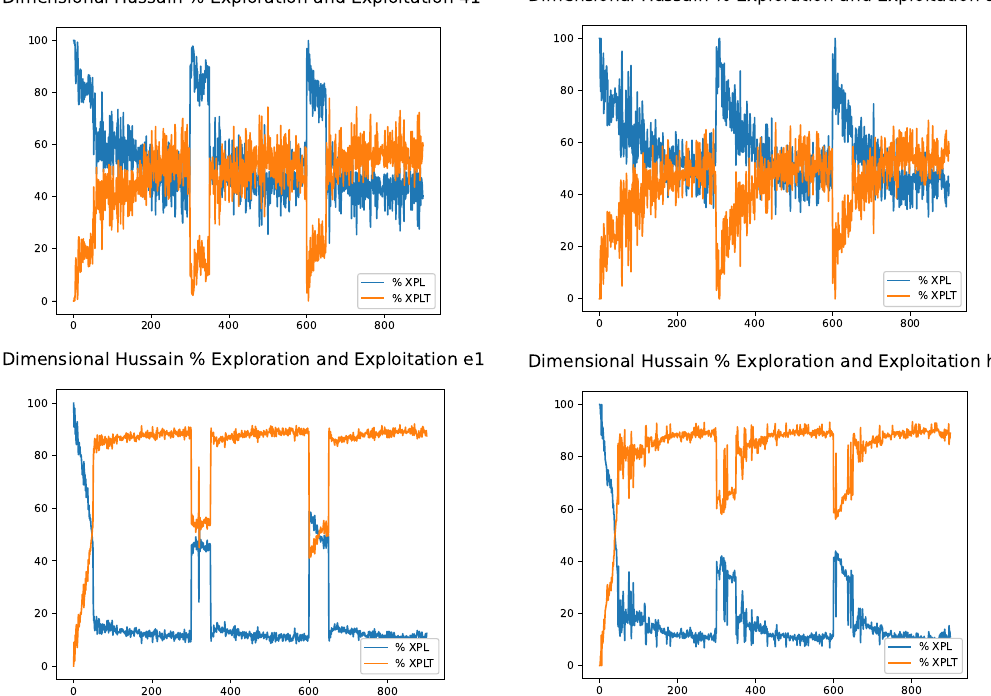
Figure 7. Exploration and exploitation percentage for original PSO. For small instances (scp41 and scpa1), the algorithm shows an exploitative behavior, for bigger instances (scpnre1 and scpnrh1), the algorithm shows an exploitative behavior. We can observe the transition between inner-phases at iterations 50, 300, and 600.